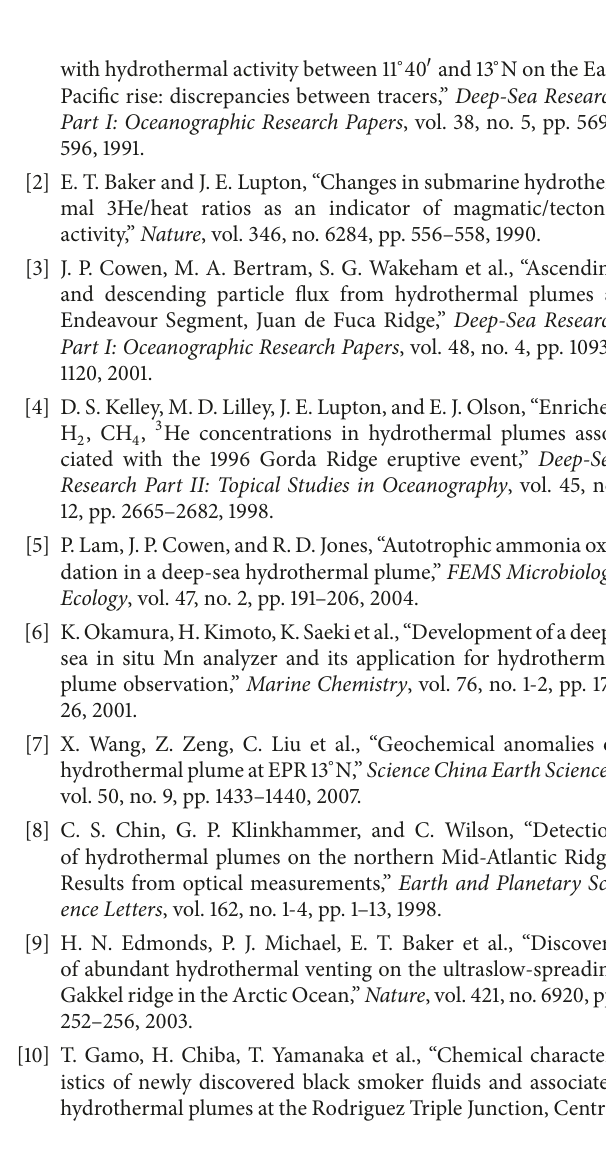
Figure 7: Vertical profiles of temperature anomaly and As/Sb ratio at Stations 18B (a), 18G (b), and 18K (c). “ ⋅ ” denotes the temperature anomaly, and “ Δ ” denotes the As/Sb ratio in the water column samples. The dashed line represents the ambient seawater As/Sb ratio (7.91). The seabed depths at Stations 18B, 18G, and 18K are 1759 m, 1606 m, and 1615m,